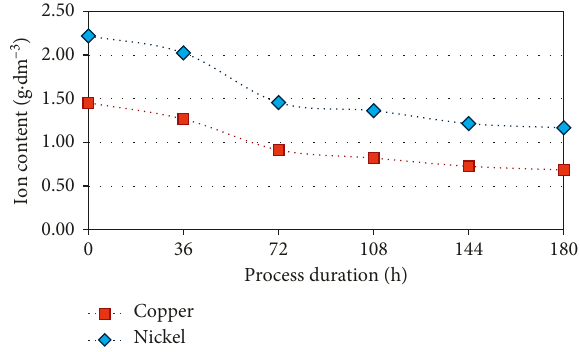
Figure 2: Content of copper and nickel ions in the electrolyte in specific stages of the cathodic reduction process ( t 2 , and T I 0.1A, i 0.0015A cm 50 ° (cid:31) (cid:31) · (cid:31) −